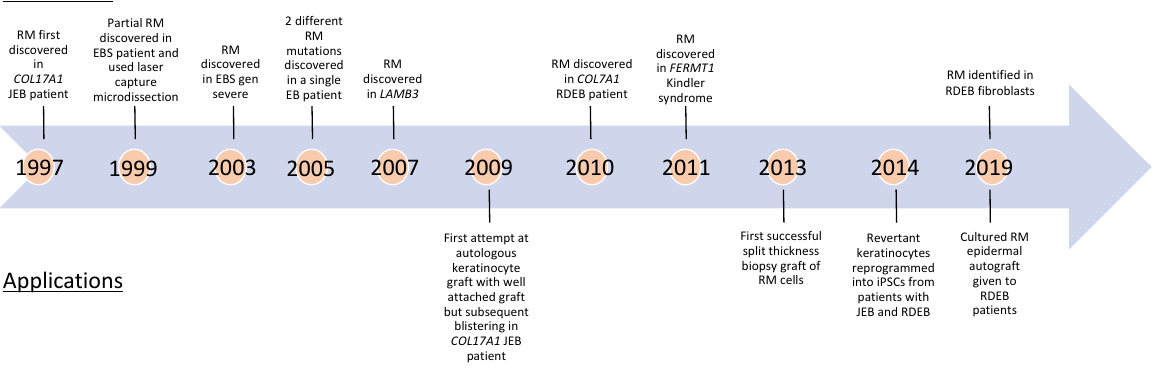
Figure 2. Timeline of discoveries in EB revertant mosaicism and clinical interventions. Table 1. Published cases of revertant mosaicism in EB keratinocytes.